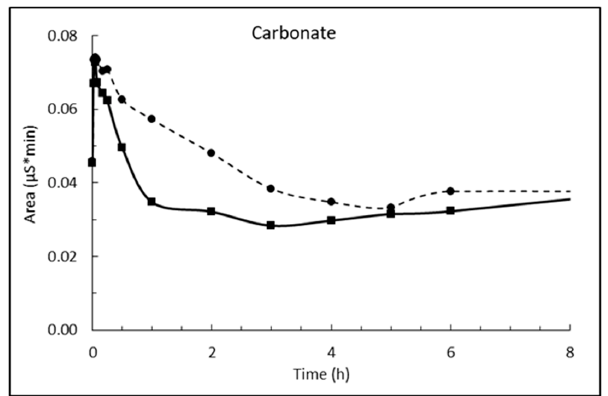
Figure 10. Relative concentration of carbonate in sea water at T = 5 °C (dashed line) and 15 °C (solid line) as function of time after adding 1% ( w / v ) fine CaO.